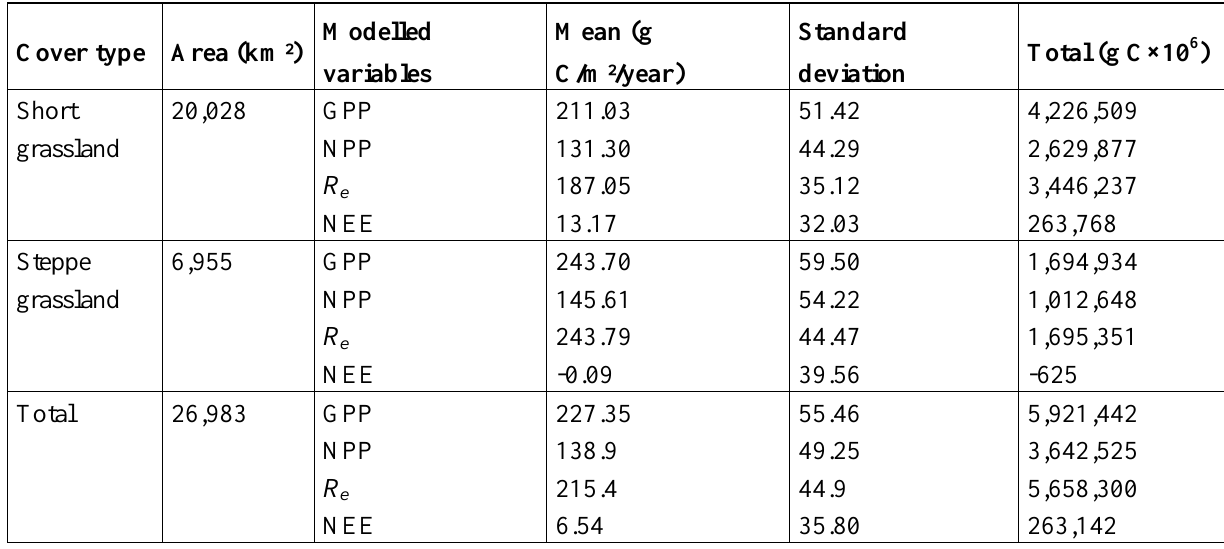
Table 3. Modelled GPP, NPP and NEE* by cover